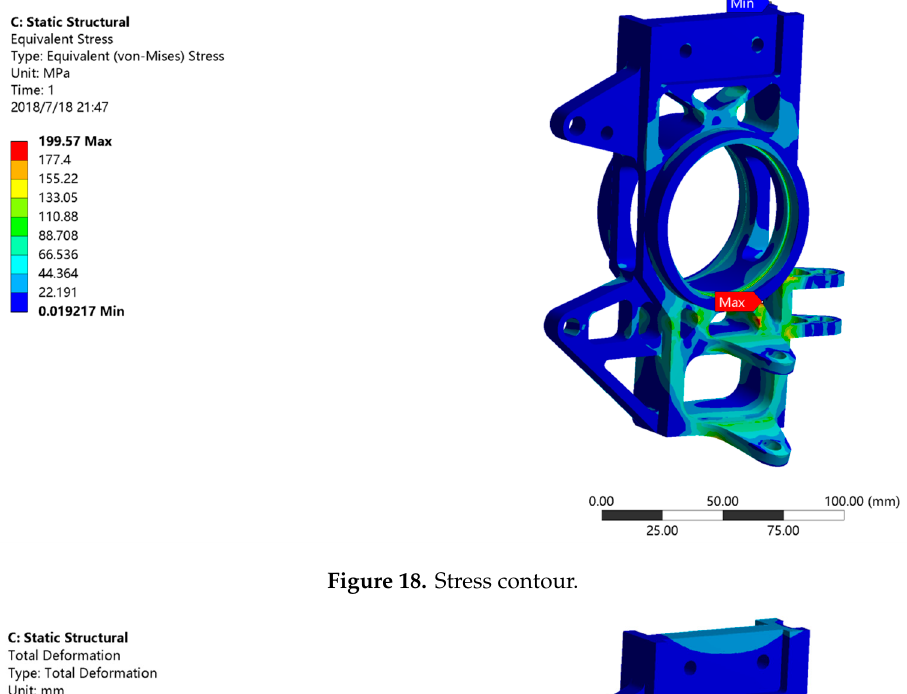
Figure 18. Stress cloud. Figure 18. Stress contour.